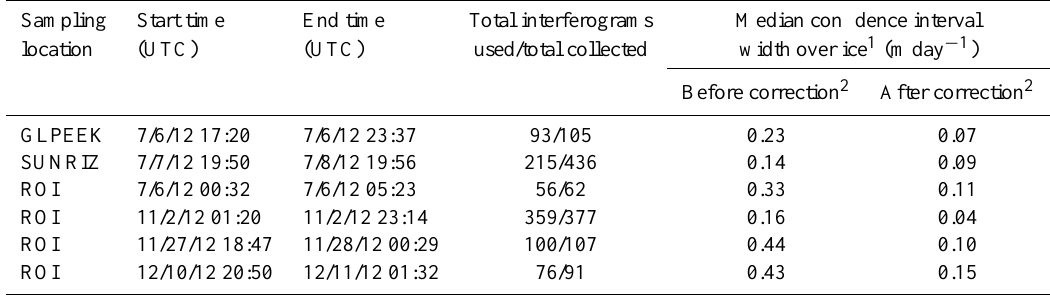
Before correction 2 After correction 2